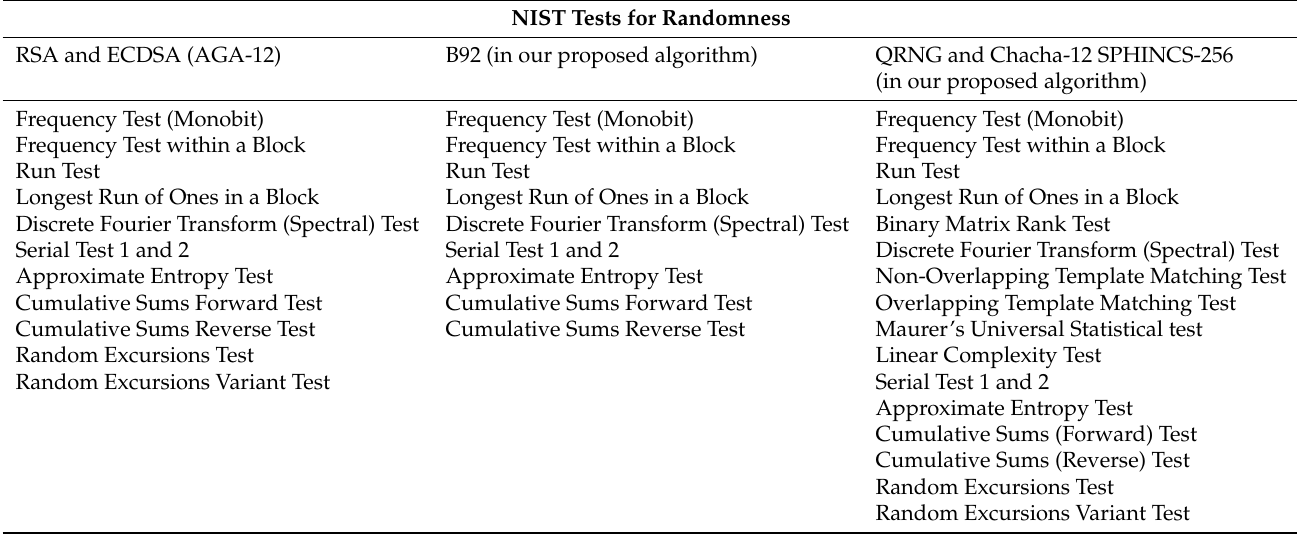
Table 3. NIST tests on